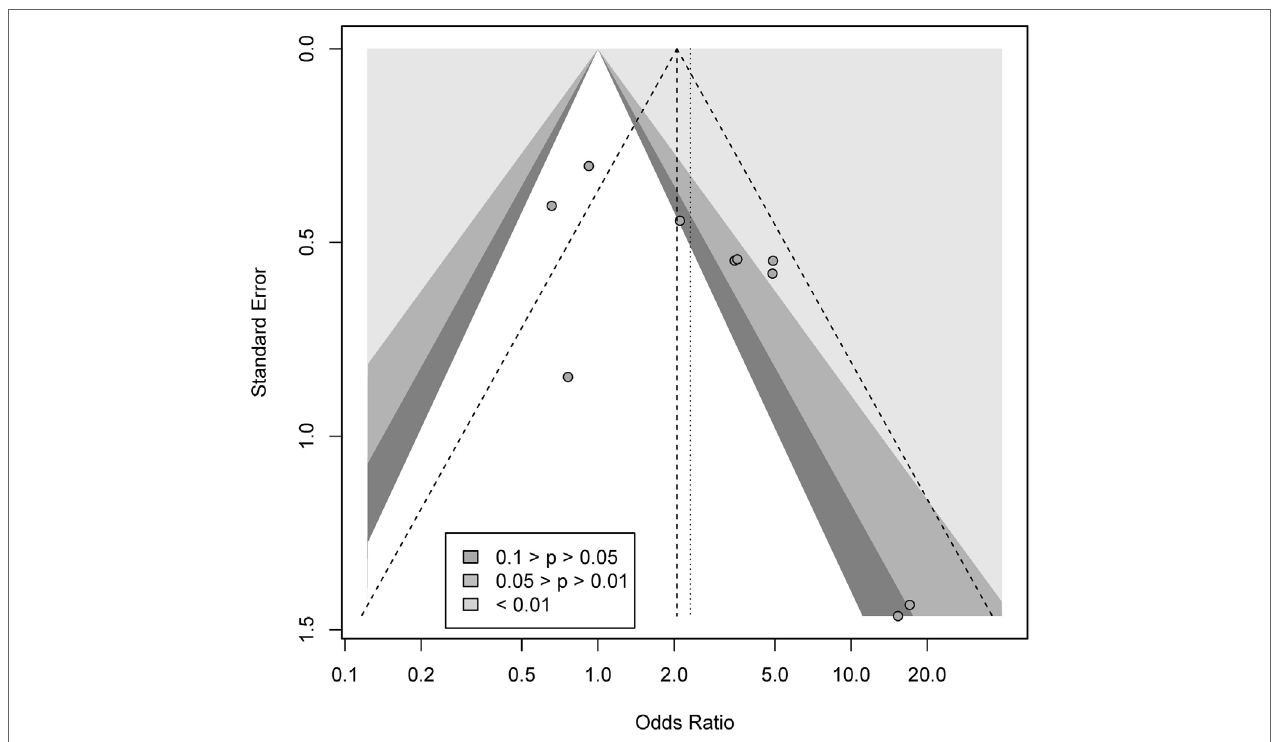
FigURe 10 | Contour-enhanced funnel plot for